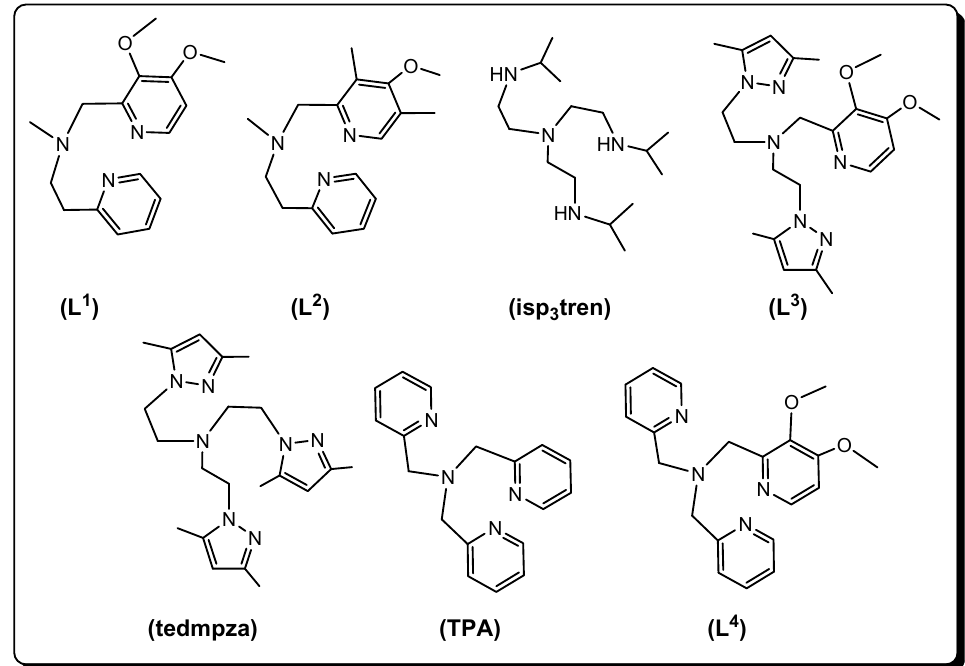
Scheme 1. Structure formulas of some N -donor ligands used in this study.